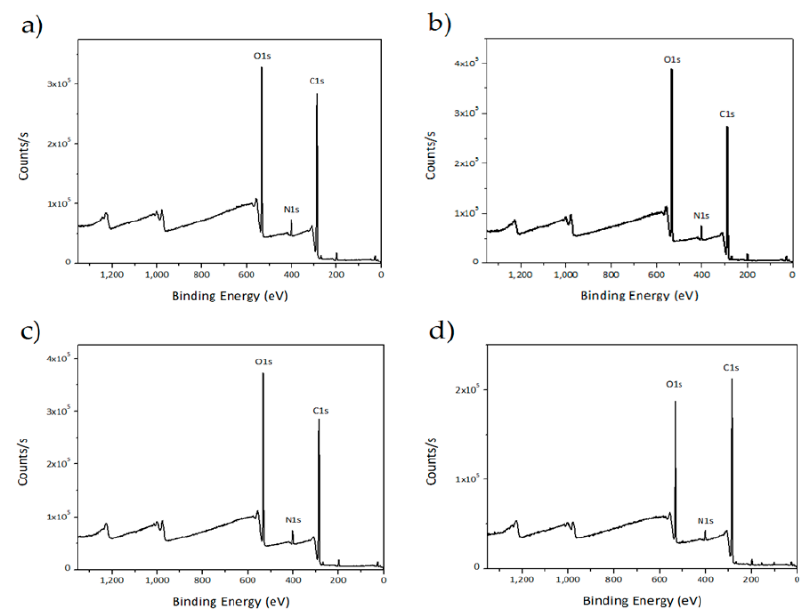
Figure 2. XPS spectra for ( a ) PVA / CHI / AMP 1:2; ( b ) PVA / CHI / 1:2; ( c ) PVA / CHI / FUC / AMP 1:2; ( d ) PVA / CHI / FUC 1:2.